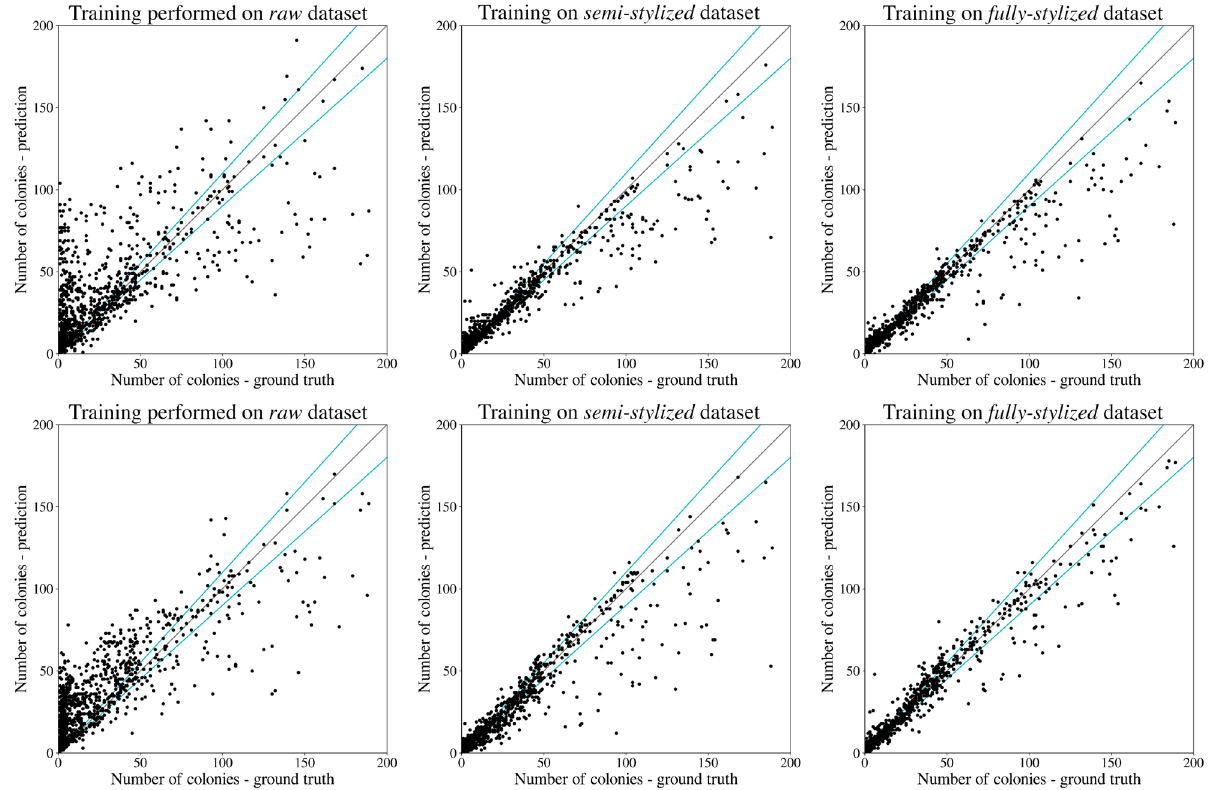
Figure 9. Microbial colonies counting tested on real data for three different synthetic training datasets: raw (left), semi-stylized (middle), and fully-stylized (right). In ideal detection every black dot representing a single Petri dish image should lay on the y = x black line. Top row shows results for Faster, while bottom row for the Cascade